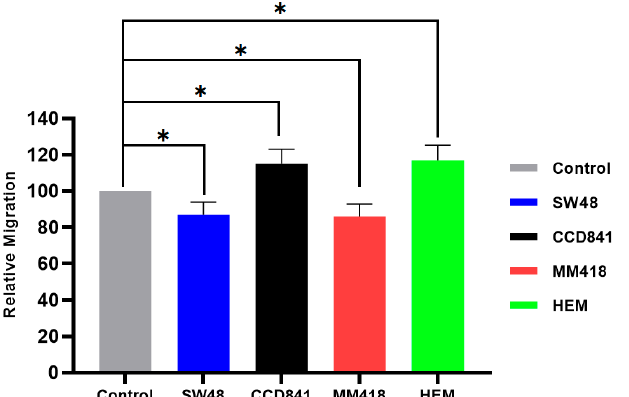
Figure 6. The effect of IR on the migration of human colon adenocarcinoma (SW48) and melanoma (MM418-C1) cell lines compared to their non-cancerous counterparts (CCD841 and HEM cells). The cells were irradiated with 5 Gy X-ray 24 h prior to the scratch test. Control represents the corresponding untreated cells in which the size of the gap closure over 24 h was expressed as 100%. Results were calculated as percentage of the corresponding untreated controls over that 24 h period and are expressed as the mean ± SEM of 3 replicates. Significance of different treatments compared to the untreated control is represented by black lines shown as * p < 0.05.